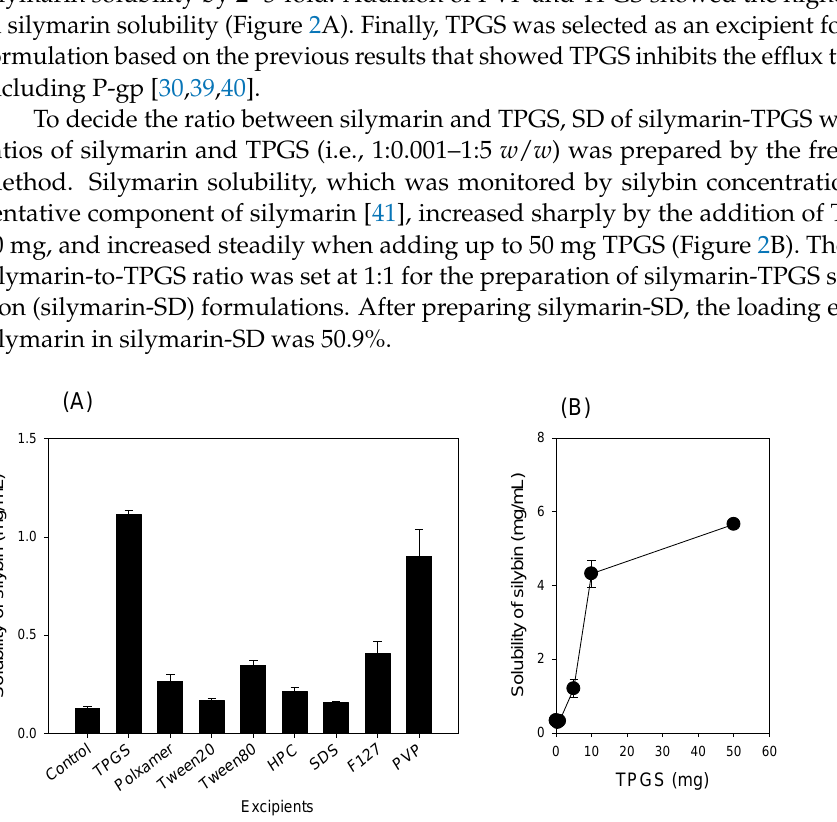
Figure 2. ( A ) Solubility of silymarin, which was monitored by silybin concentration, was measured in the presence of TPGS, Poloxamer407 (Poloxamer), Tween 20, Tween 80, hydroxypropyl cellulose (HPC), sodium dodecyl sulfate (SDS), pluronic F127 (F127), and polyvinylpyrrolidone (PVP). ( B ) Solubility of silymarin in the presence of varying amount of silymarin after preparing solid dispersion by freeze drying method. Each data represents mean ± standard deviation of triplicated determination.